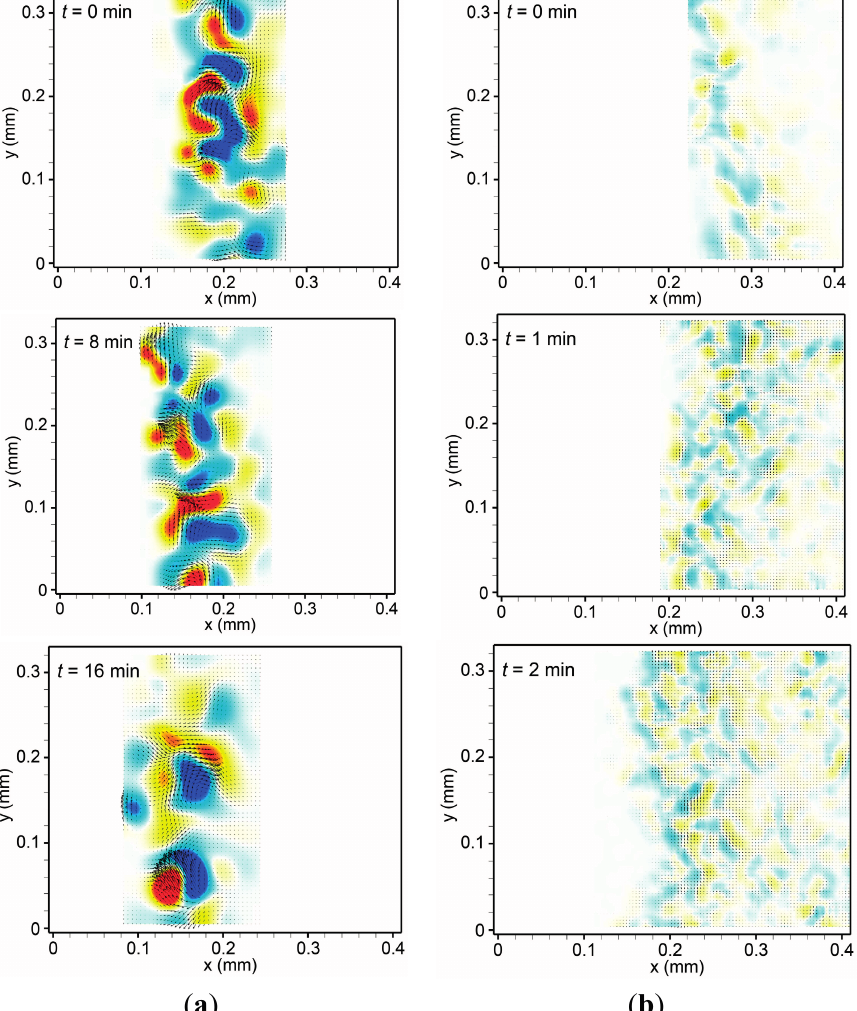
Figure 4. Instantaneous velocity (arrow) and vorticity (color) maps of swarm colony flow near the advancing edge of the B. subtilis colony at different time points in ( a ) slow spreading and ( b ) fast spreading mode. Scales of the velocity vector and vorticity are same with Figure